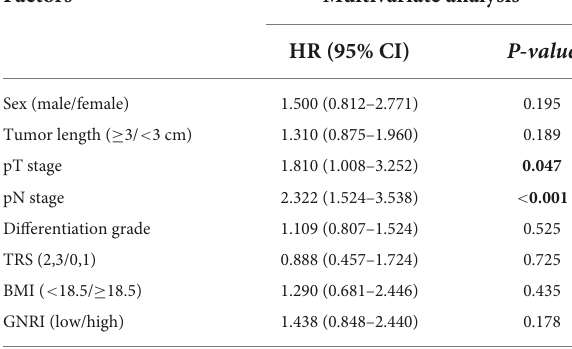
TABLE 5B Multivariate analysis of prognostic factors associated with disease-free survival.